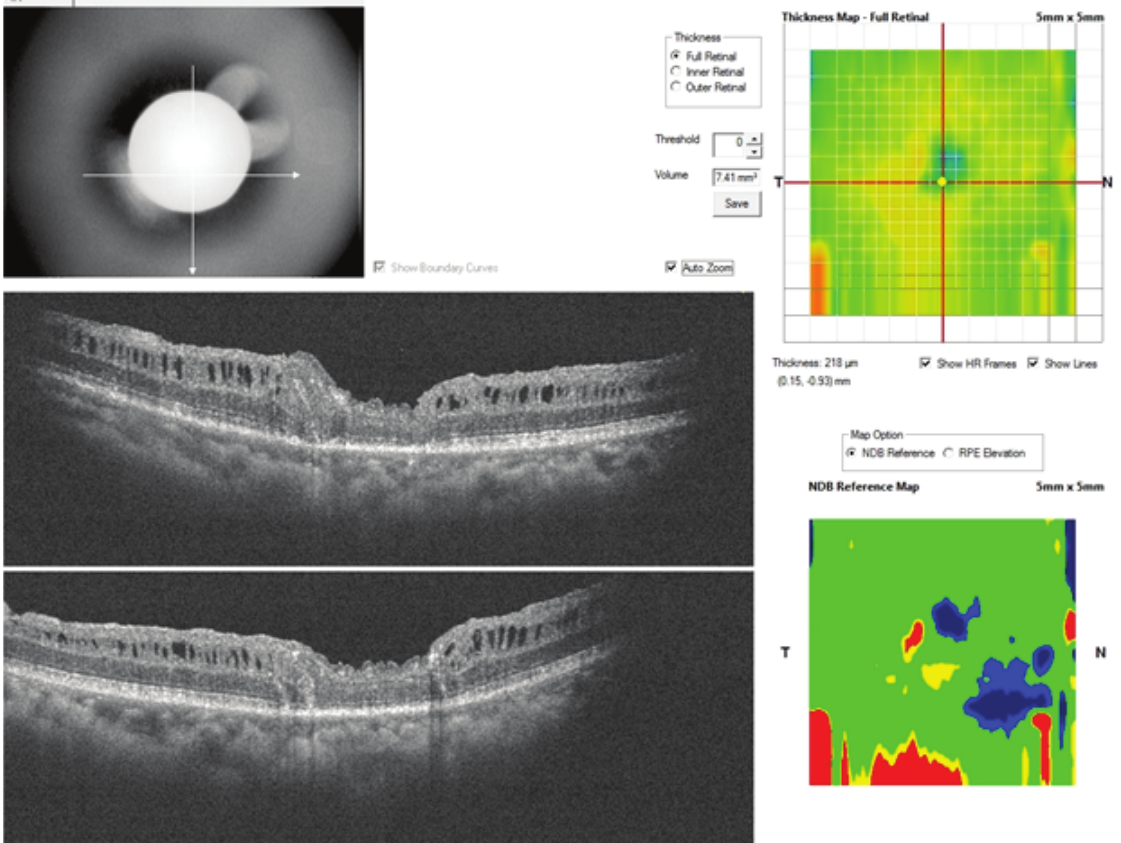
Figure 3. Patient 1; postoperative OCT cross-line horizontal and vertical scans showing integration of the ellipsoid zone of the retina graft tissue with the adjoining host retinal